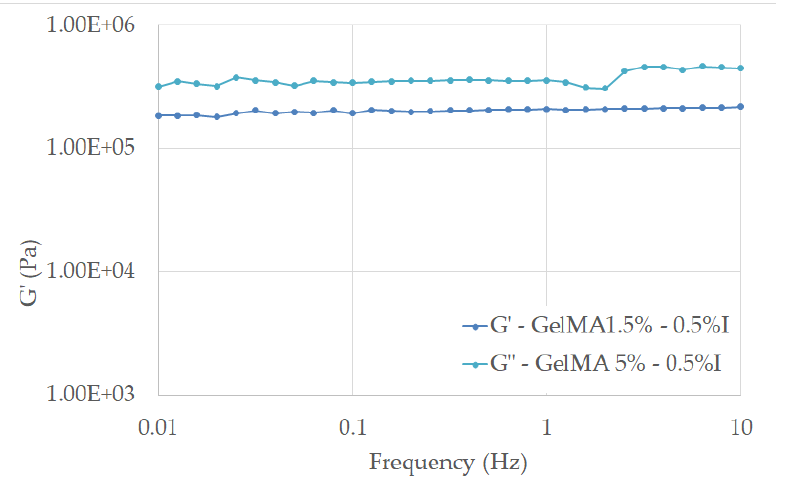
Figure 13. Storage modulus for the crosslinked hydrogels based on 1.5% GelMA with 1% I and 5% GelMA with 1% I as functions of frequency measured at 25 °C under a stress of 5 Pa.